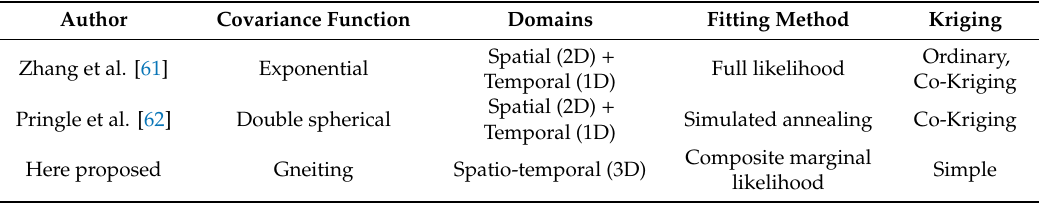
Table 5. Spatial and temporal statistical approaches for gap-filling remote sensing